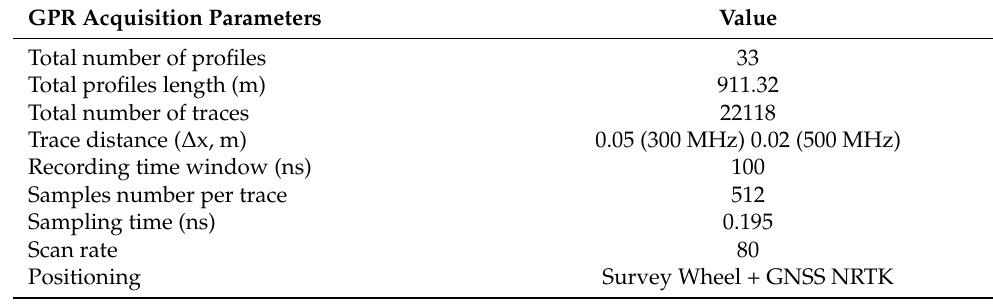
Table 1. Main GPR parameters used during the acquisition at the study site. Another table reporting the detailed parameters for each GPR profile can be found in the Supplementary Material (Table S2).